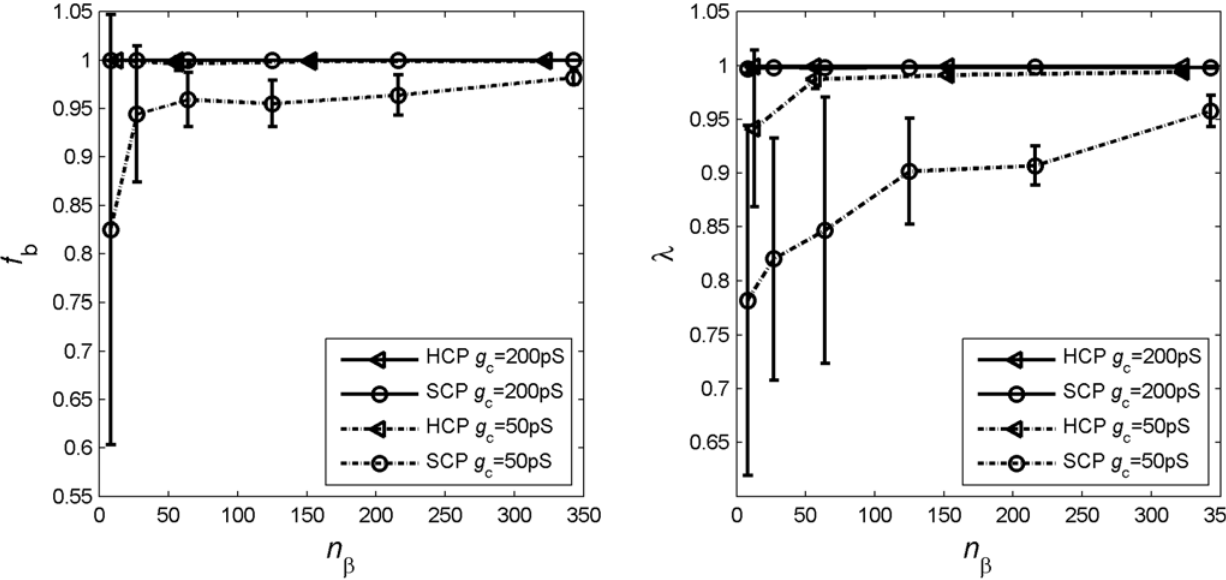
Figure 2. The fraction of b cells able to burst f b , and their synchronization l , are less influenced by cluster size n b in HCP clusters. Plotted are mean and standard deviation of the corresponding 10 replicate clusters at each condition.